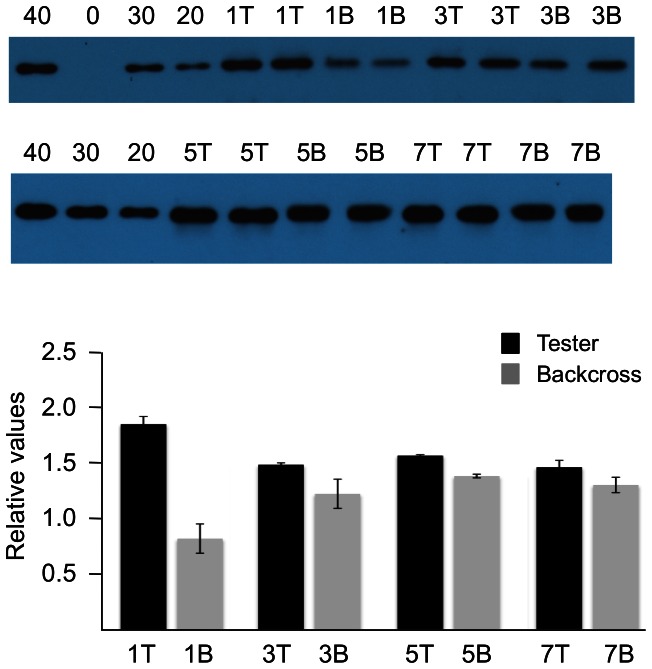
Immunoblotting validates ssp1 as an empty container.Duplicate one microgram aliquots of total seed protein from tester and backcross homozygotes were subjected to SDS-PAGE and immunoblotting with an anti-PHA antibody. Reporter lines 1, 3, 5, and 7 are shown in duplicate as testers (T) and the corresponding backcrosses (B). Aliquots of purified PHA were included as standards. The autoradiographs were scanned by densitometry and quantified by employing Image J software. The bar graphs represent the average PHA values relative to 30 ng of purified PHA. T-test statistical analyses revealed that lines 1, 3, and 5 have p-values less than 0.05, while the line 7 p-value was greater than 0.05. An independent experiment on the previous generation of these tester/backcross lines revealed similar enrichment trends and p-values.